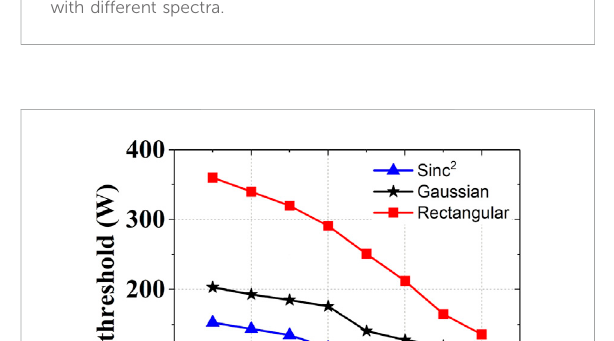
FIGURE 3 The re fl ectivity versus the output power of fi ber ampli fi ers with different spectra.